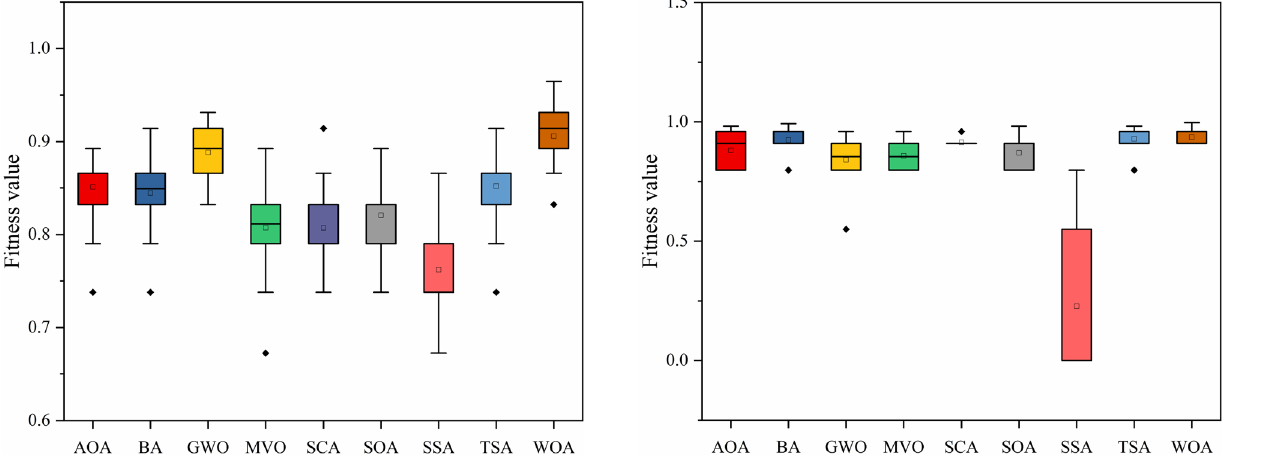
Fig. 14 The ANOVA tests of the algorithms for case